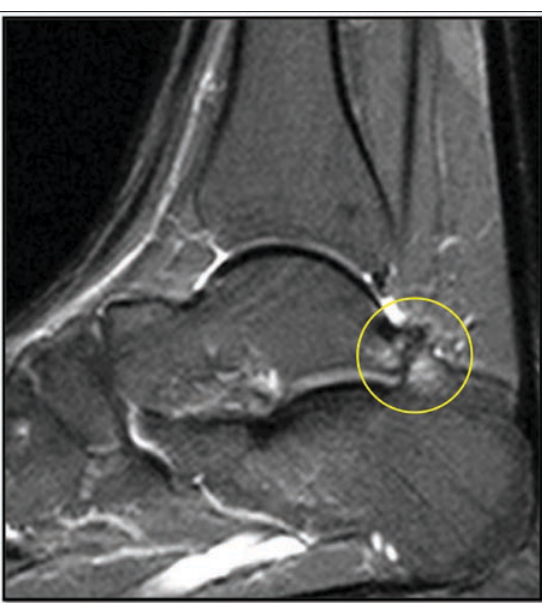
Figure 2. Sagittal fat suppressed proton density MR image, showing the bone marrow edema in Stieda process and in Haglund’s deformity (area circled in yellow).